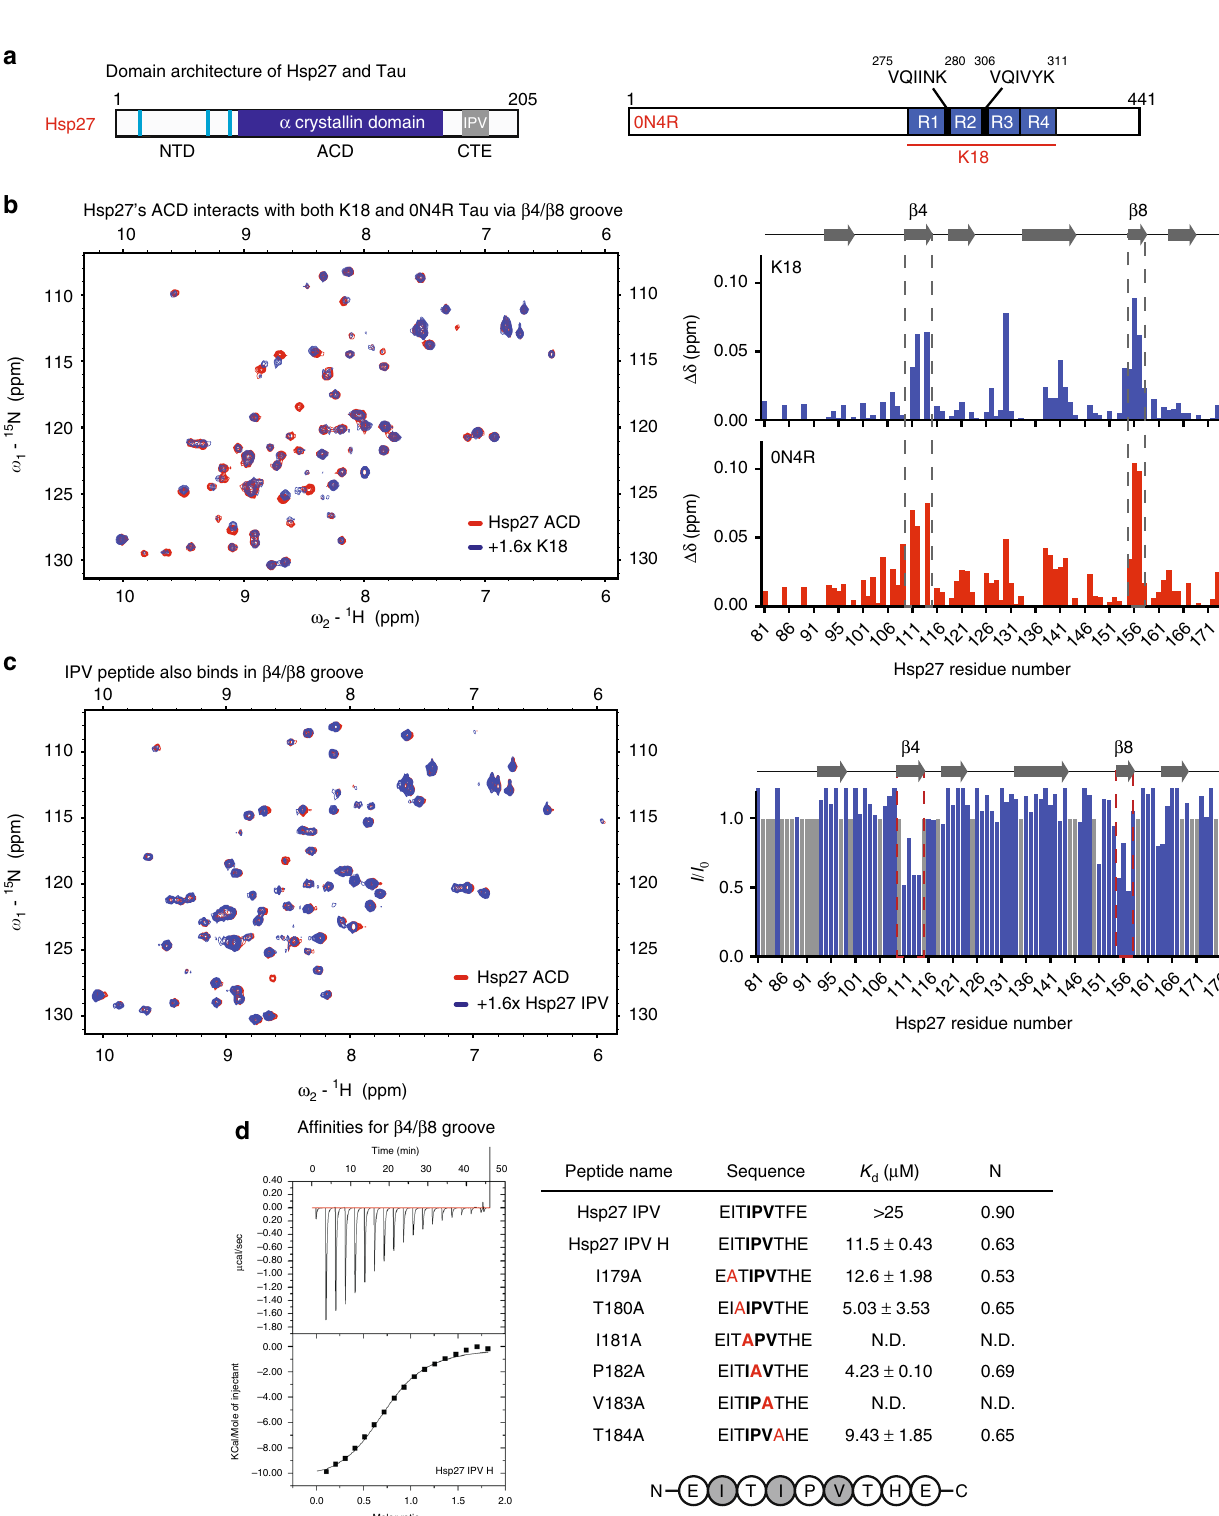
Fig. 1 Hsp27 ’ s β 4/ β 8 groove is a PPI hot spot for both client- and self-interactions. a Domain architecture of Hsp27 and Tau isoforms. b Left, HSQC spectra of 15 N Hsp27 ACD alone (150 µ M, red) or in the presence of 250 µ M K18 (blue). Right, chemical shift perturbations in ACD upon binding of 250 µ M K18 (top) or 0N4R (bottom). c Left, intensity ratios upon binding of Hsp27 IPV peptide, with unassigned residues shown in gray. Right, HSQC spectra of 15 N Hsp27 ACD alone (150 µ M, red) or in the presence of 250 µ M Hsp27 IPV peptide (blue). d Isothermal calorimetry of Hsp27 ACD with IPV-derived peptides. Left, representative ITC curve for Hsp27 IPV H peptide. Right, table of af fi nity values. ND, no detectable binding. Values are represented as mean ± standard error of the mean (SEM) determined from a minimum of three independent experiments. Bold letters highlight the mutated